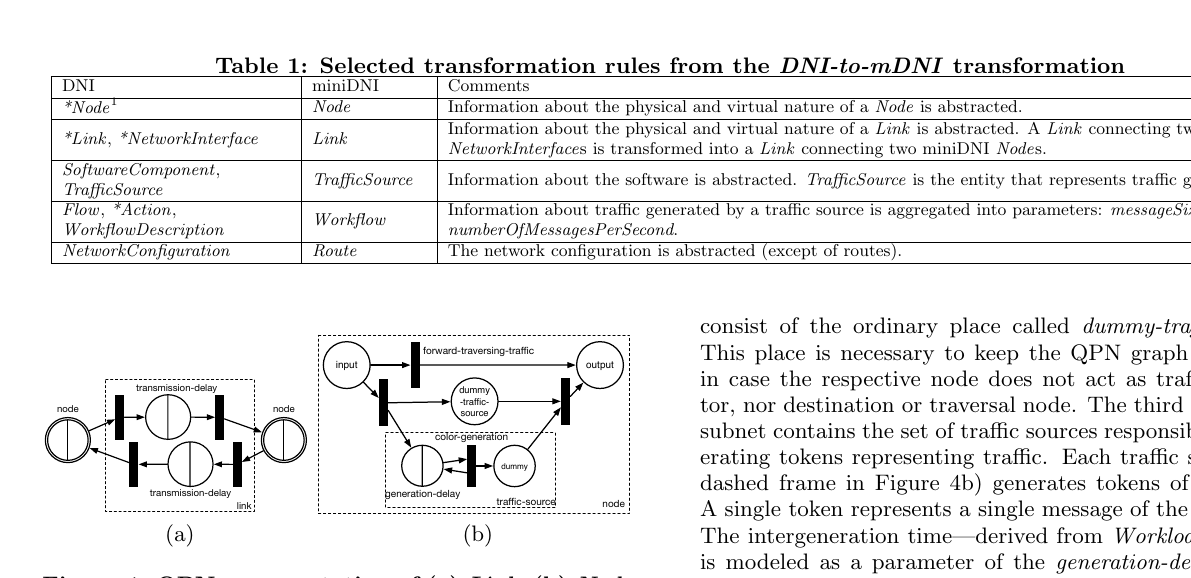
Figure 4: QPN representation of (a) Link , (b) Node , and TrafficSource in the mDNI-to-QPN transforma-